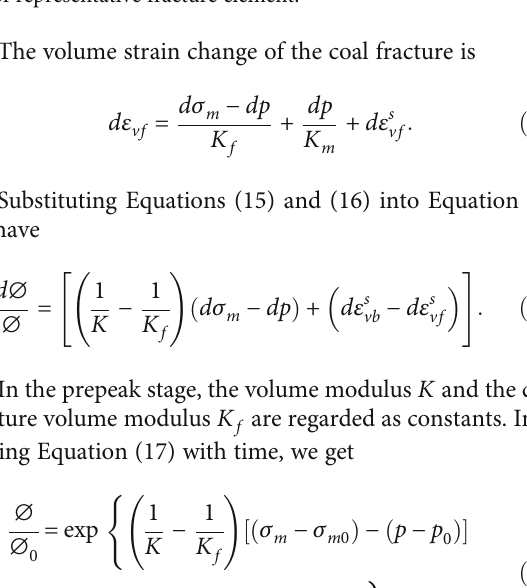
Figure 6: Stress state decomposition diagram of representative fracture